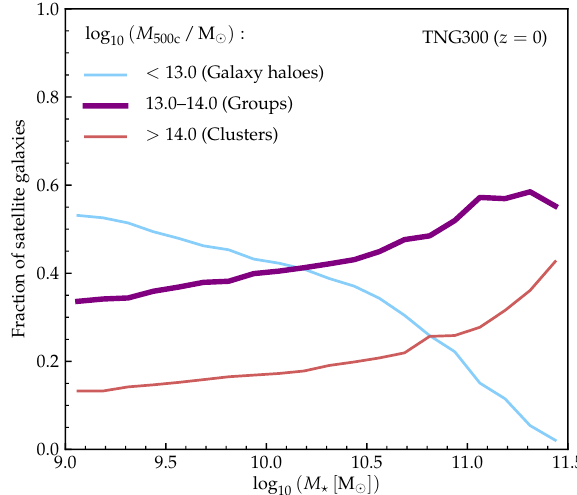
Figure 13. Fraction of satellite galaxies in the IllustrisTNG300 simulation that are hosted by galaxy- scale halos ( M 500c < 10 13 M , light blue), groups ( M 500c = 10 13 –10 14 M (cid:12) ( M 500c > 10 14 M , light red), respectively, as a function of their stellar mass. Groups host around (cid:12) a third of low-mass satellites, and more than half of those with M (cid:63) exceeds that of clusters at all stellar masses shown